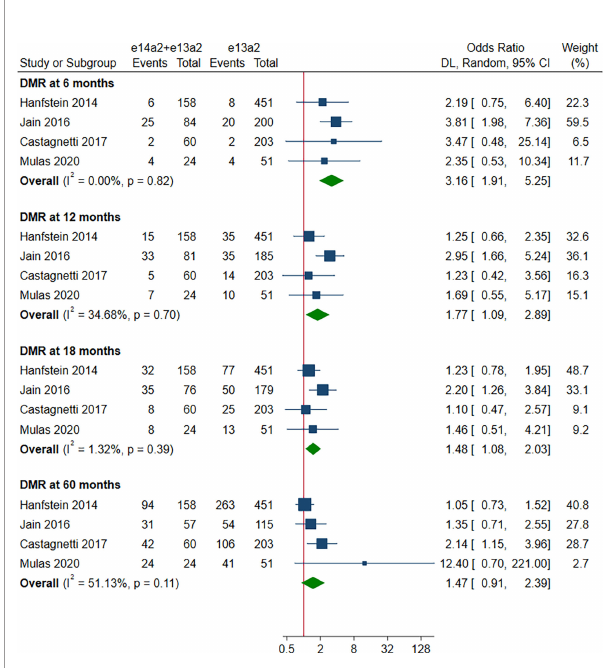
FIGURE 5 | E14a2 + e13a2 versus e13a2: rate of patients who achieved deep molecular response at 6, 12, 18 and 60 months.